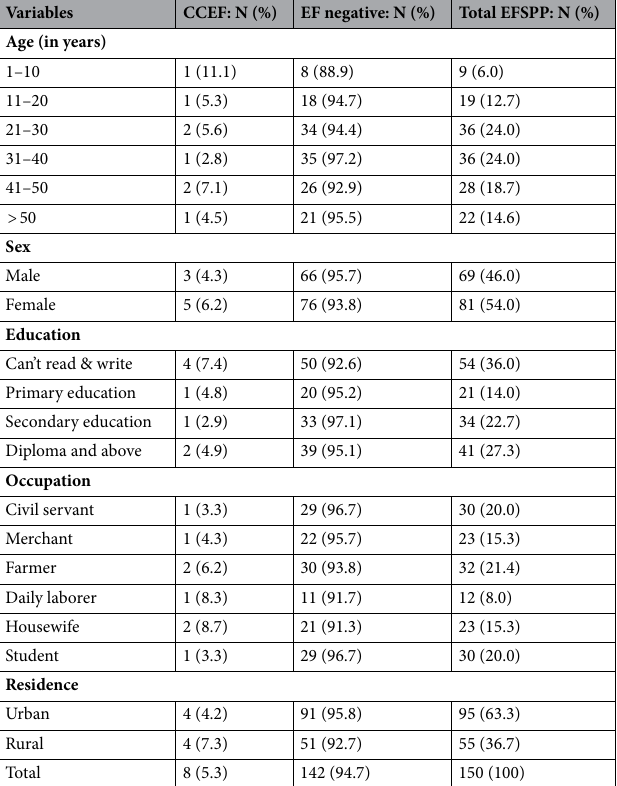
Table 1. Prevalence of enteric fever among different socio-demographic variables of study participants (n = 150) at FHCSH, Bahir Dar, Northwest Ethiopia, 2020. CCEF culture confirmed enteric fever, N number, EFSPP enteric fever suspected patients processed.